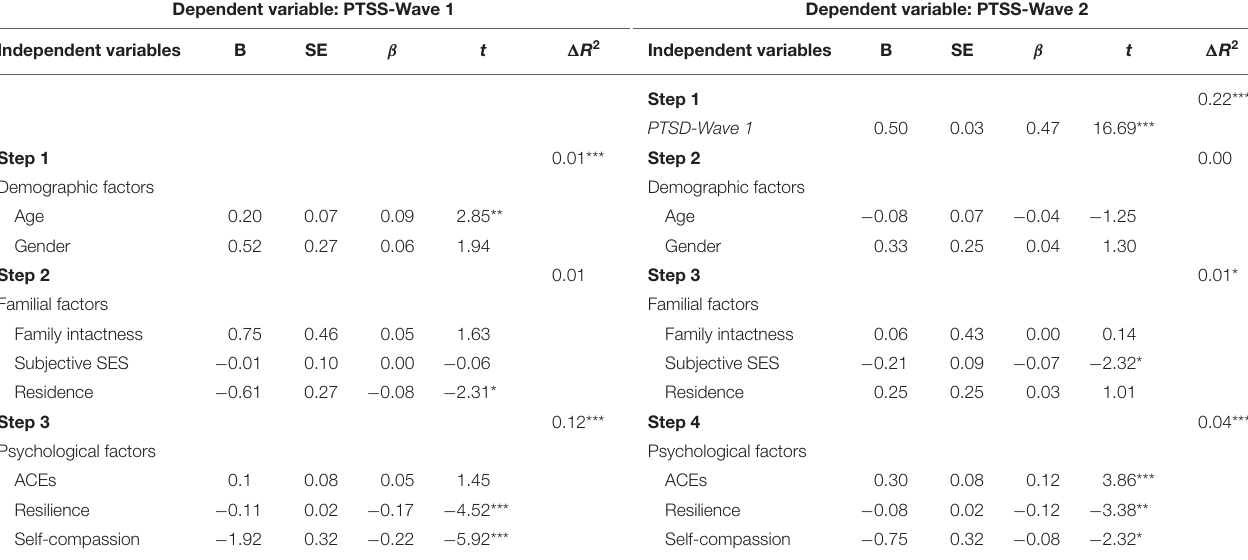
TABLE 4 | Multiple linear regression of predictors of PTSS in Waves 1 and 2 (February 2020 and August 2020). Dependent variable: PTSS-Wave